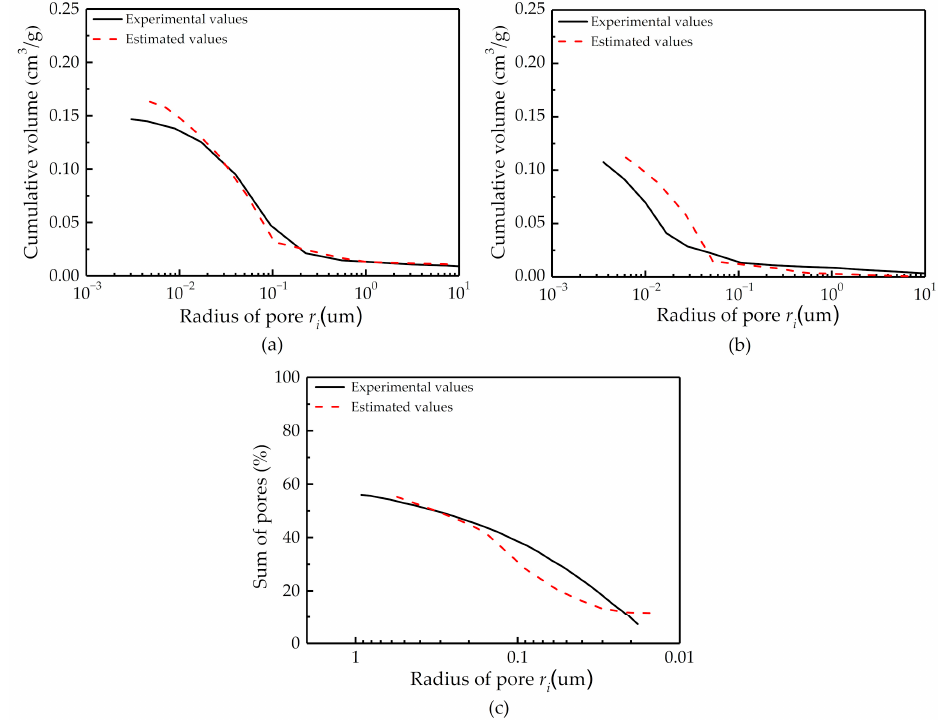
Figure 12. Comparison of the pore size distribution determined by SFC and by MIP. ( a ) Xiao [41]; ( b ) You et al. [40]; ( c ) Fagerlund [42].